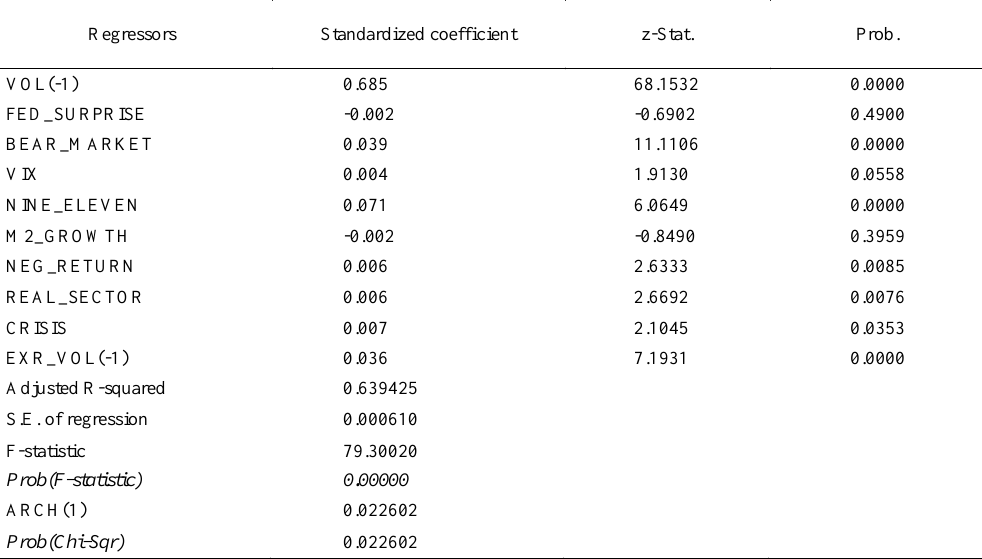
Table 2: GARCH estimates of volatility of S&P 500